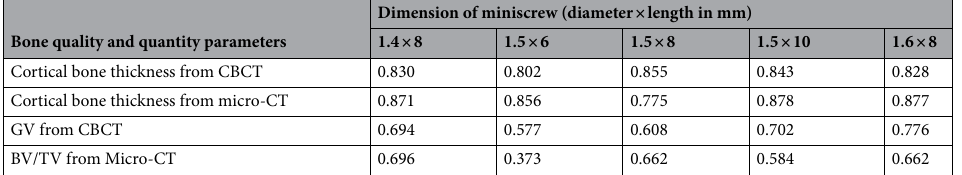
Table 3. Relationship between BMC% and bone quality for different miniscrew dimensions. Except for the relationship between BV/TV measured from micro-CT and BMC% in the 1.5 × 6 mm group, all relationships had P values less than